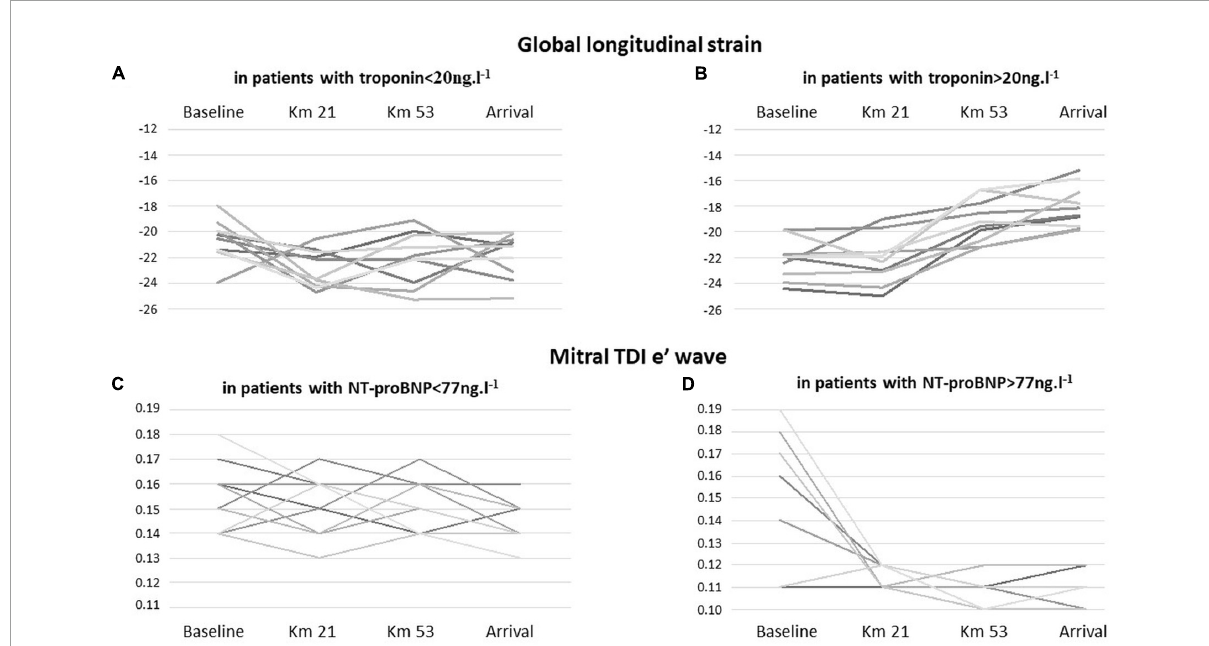
FIGURE1 Individual changes in global longitudinal strain in runners according to the results of troponin during the race [ (A) troponin levels < 20 ng.l − 1 versus (B) troponin levels > 20 ng.l − 1 ]. Individual changes in mitral TDI e’ wave in runners according to the results of NT-proBNP during the race [ (C) NT-proBNP < 77 ng.l − 1 versus (D) NT-proBNP > 77 ng.l − 1